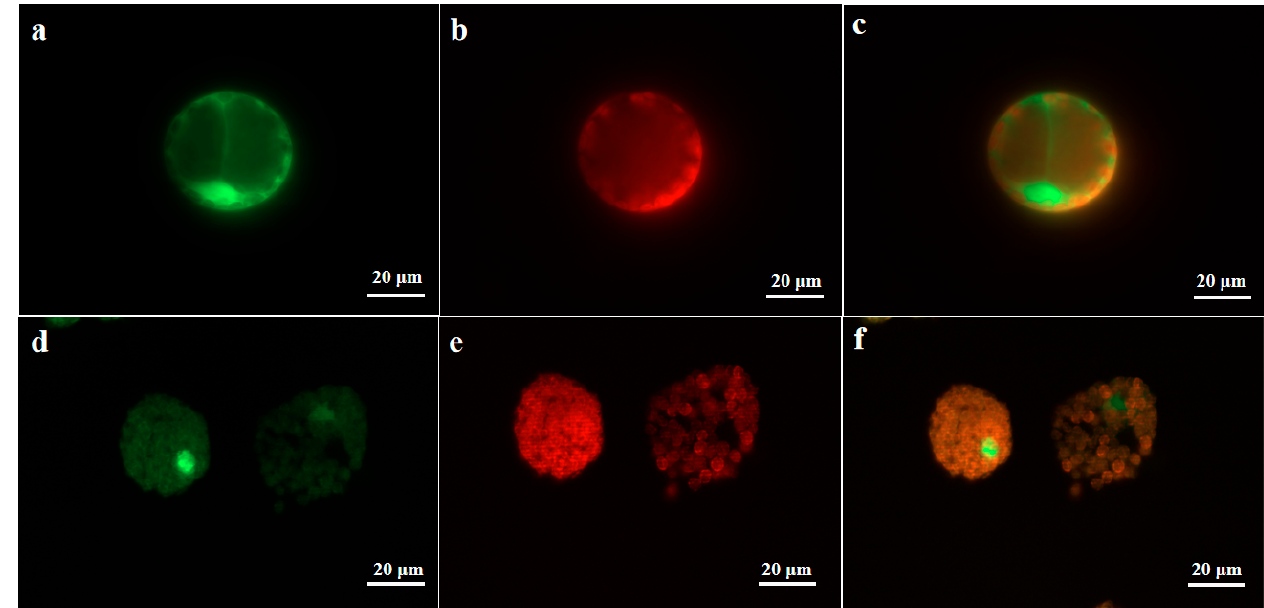
Figure 5. Schematic diagram of extraction, purification, and transformation process of U. rhyncho- phylla protoplasts.